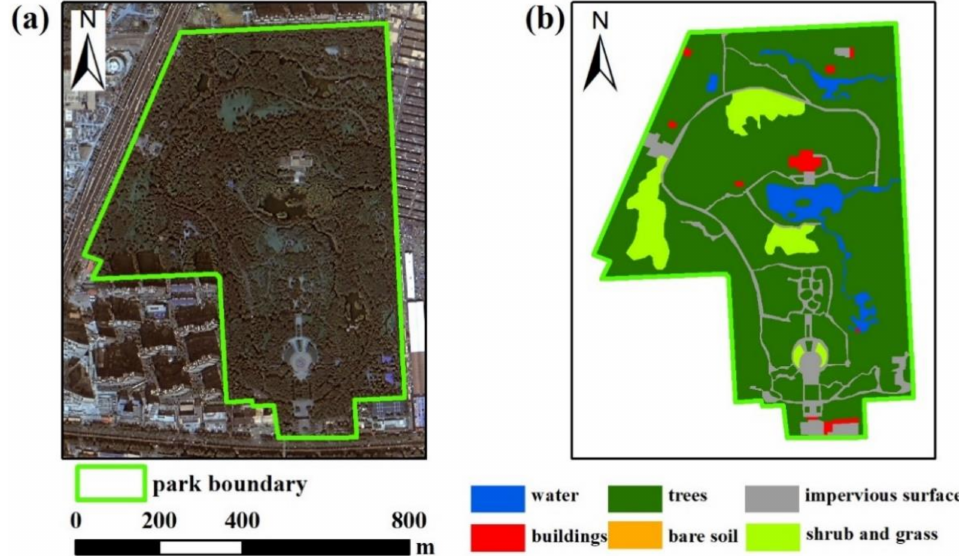
Figure 2. ( a ) GF-2 image (true color) of an urban park. ( b ) Land-cover map of an urban